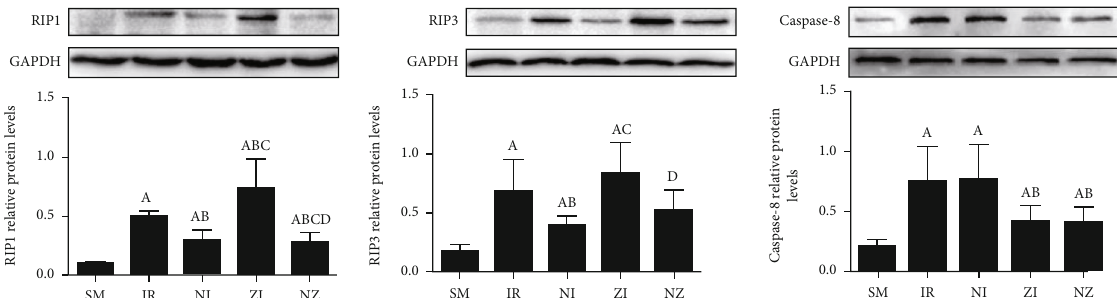
Figure 5: Protein expressions of RIP1, RIP3, and caspase-8. The rats were randomly divided into fi ve groups. Brie fl y, the rats in the SM group received sham operation, while the left lung hilum was subjected to 1h of ischemia followed by reperfusion up to 3h in the IR group. Intraperitoneal Nec-1 (1 mg/kg) and z-VAD-fmk (3 mg/kg) were administrated before lung ischemia in NI and ZI groups, respectively, and combined administration of Nec-1 and z-VAD-fmk was given in the NZ group. After 3 h of reperfusion, protein expressions of RIP1, RIP3, and caspase-8 were measured by Western bolt. RIP1: receptor-interacting protein 1; RIP3: receptor-interacting protein 3. Data were presented as mean ± SD , n = 8 in each group. a P < 0 : 05 compared with the SM group, b P < 0 : 05 compared with the IR group, c P < 0 : 05 compared with the NI group, d P < 0 : 05 compared with the ZI group.